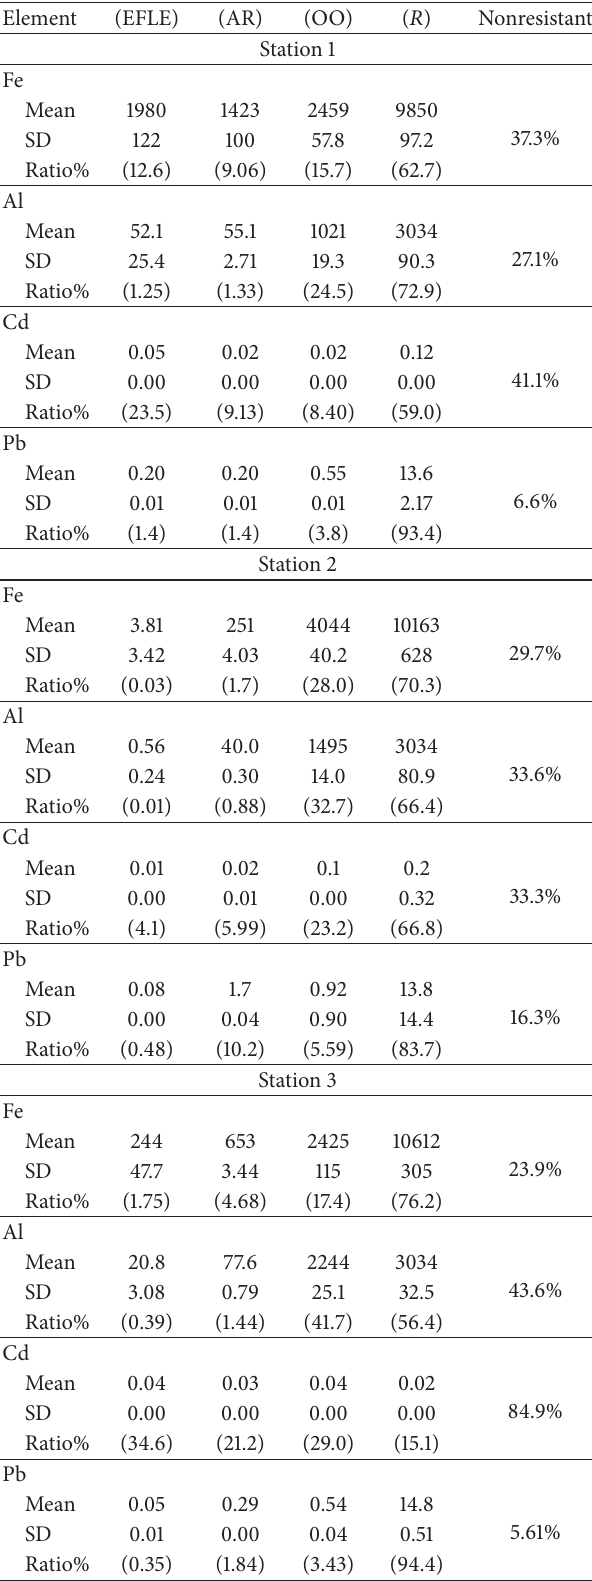
Table 6: The mean concentration ( 𝜇 g/g) and percentages (%) of Pb, Al, Cd, and Fe in the surface sediments from five different stations of the Bukit Besi ex-mine